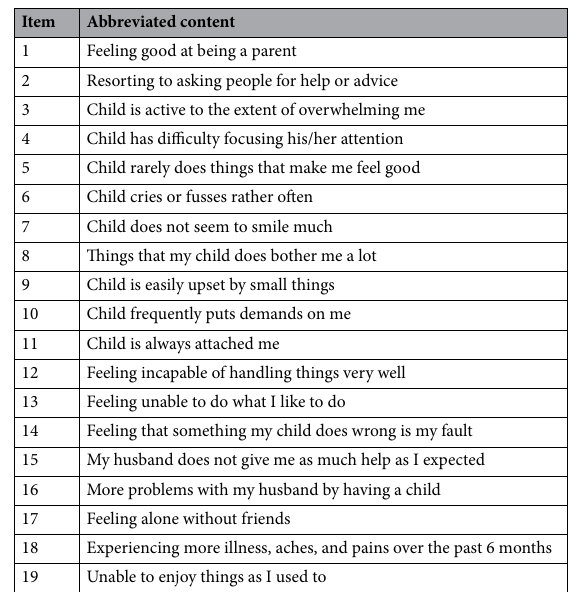
Table 1. Abbreviated content of questionnaire items for the 19-item Parenting Stress Index-Short Form employed in the Japan Environment and Children’s